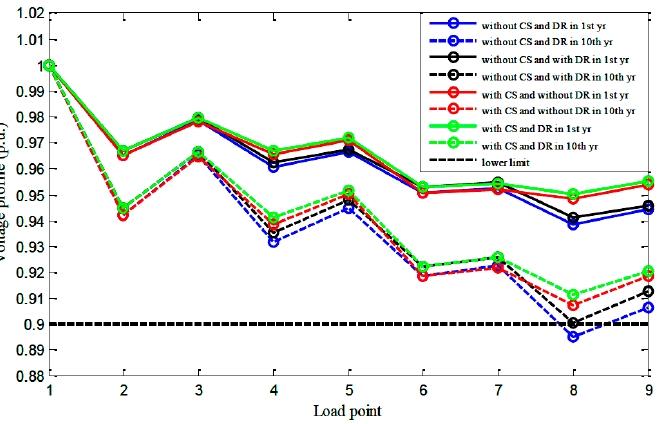
Figure 13. Voltage curve of the studied network in different scenarios and 10-year load growth application considering two parking spaces of electric vehicles.